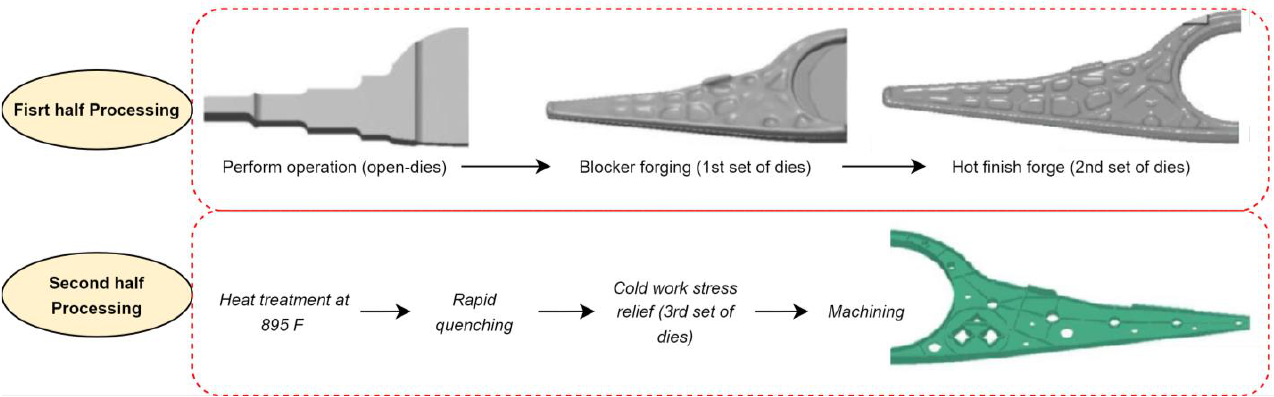
Figure 24. Overview of fictional bulkhead fabrication through existing die forging process followed by Alcoa corporation.